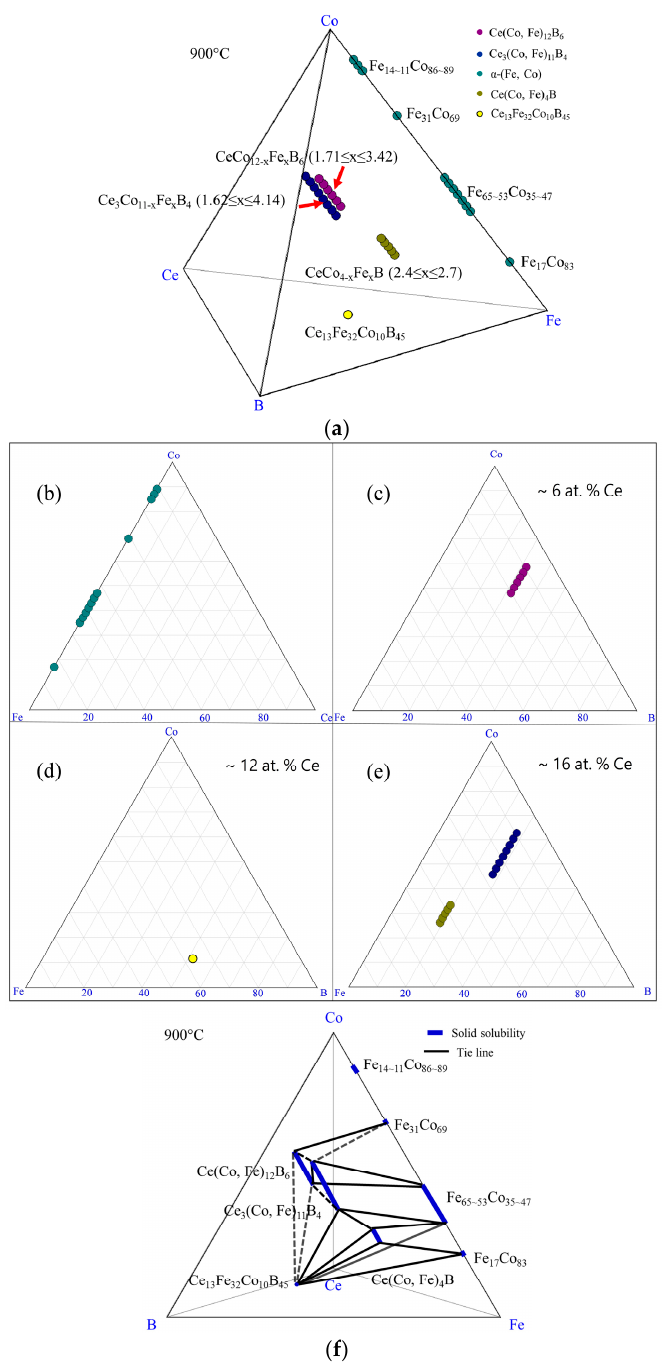
Figure 8. The results of the diffusion couple 4 at 900 °C: ( a ) 3D presentation of the experimental results; ( b ) Fe-Ce-Co ternary system; ( c ) pseudo ternary section at ~6 at. % Ce; ( d ) pseudo ternary section at ~12 at. % Ce; ( e ) pseudo ternary section at ~16 at. % Ce; ( f ) phase relations obtained from DC4.